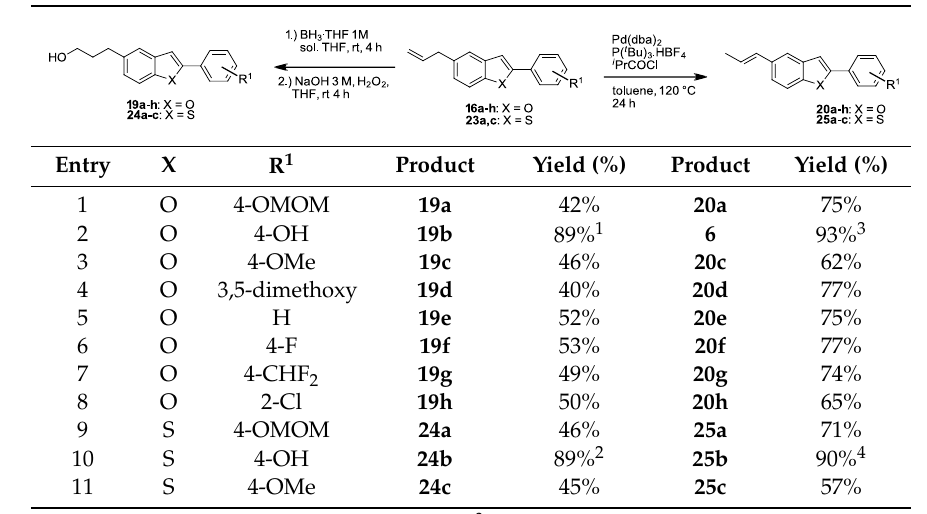
Table 2. Hydroboration-oxidation and isomerization.